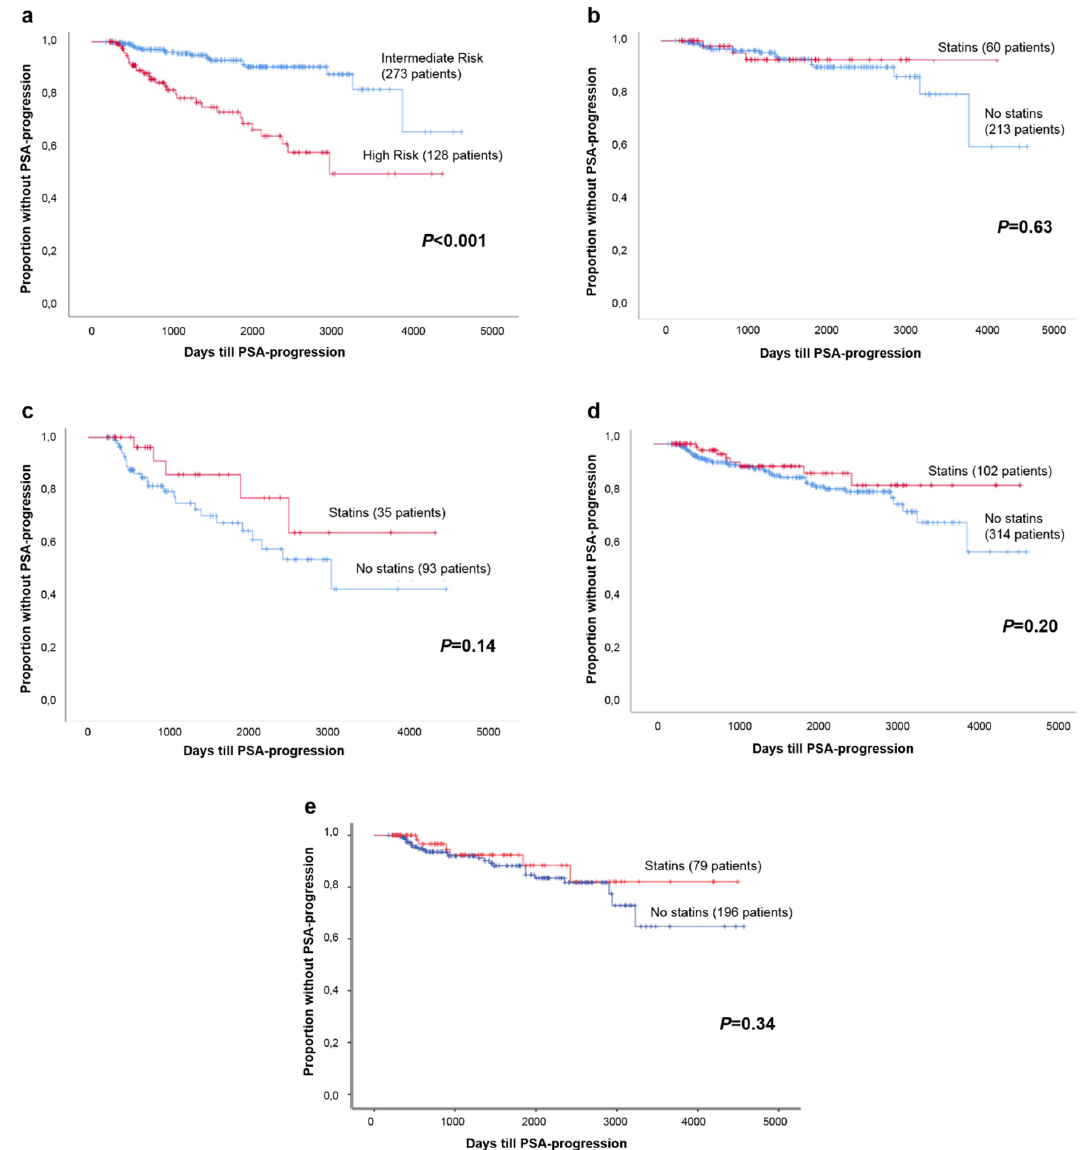
Figure 2. ( a ) Survival analysis; chance of developing BCR between intermediate-risk group and high-risk group; ( b ) Survival analysis; chance of developing BCR between statin users and non-statin users; ( c ) Survival analysis; chance of developing BCR between statin users and non-statin users in the intermediate-risk group; ( d ) Survival analysis; chance of developing BCR between statin users and non-statin users in the high-risk group; ( e ) Survival analysis; chance of developing BCR between statin users and non-statin users in the BMI ≥ 25 kg/m 2 group.